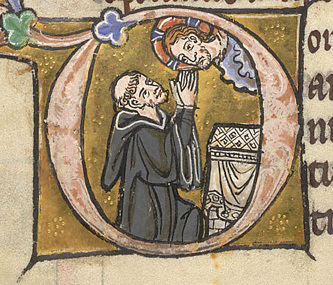
The thirteenth-century medieval scribe, the ‘Tremulous Hand of Worcester’ is known for the tremor visible in his script. Thorpe & Alty combine historical analysis with the first neurological study of the scribe’s handwriting. After considering various differential diagnoses, they conclude that the balance of evidence favours essential tremor.